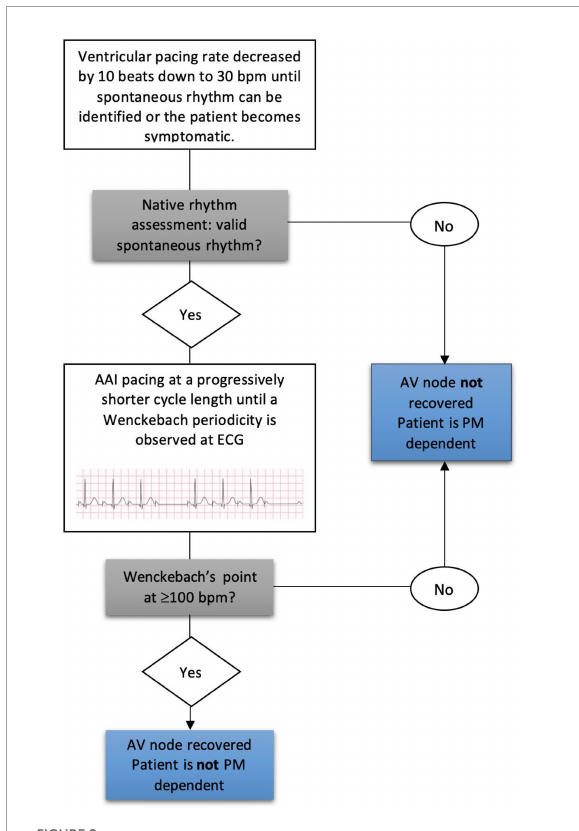
FIGURE2 Wenckebach point determination at follow-up and pacemaker dependency assessment. AV, atrioventricular; PM,